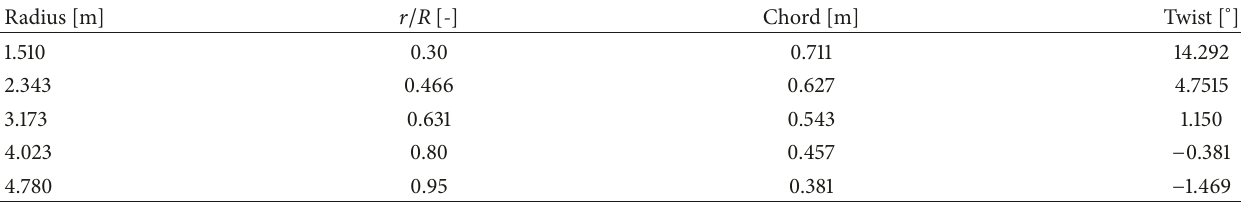
Table 2: NREL phase VI blade chord and twist distributions.